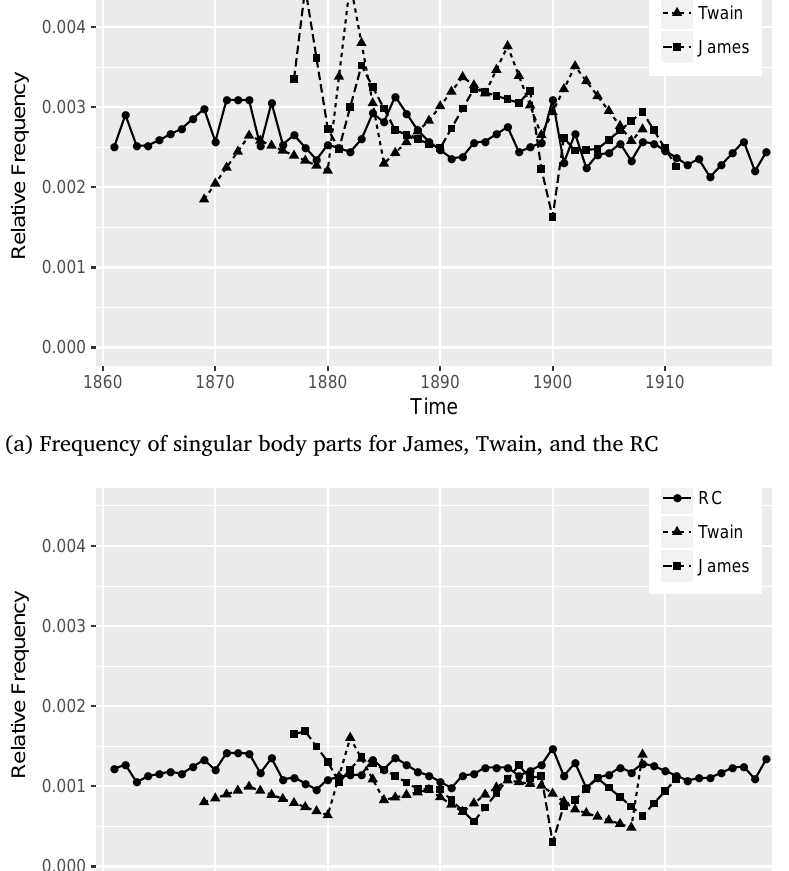
Figure 9: Body part constructions for all three